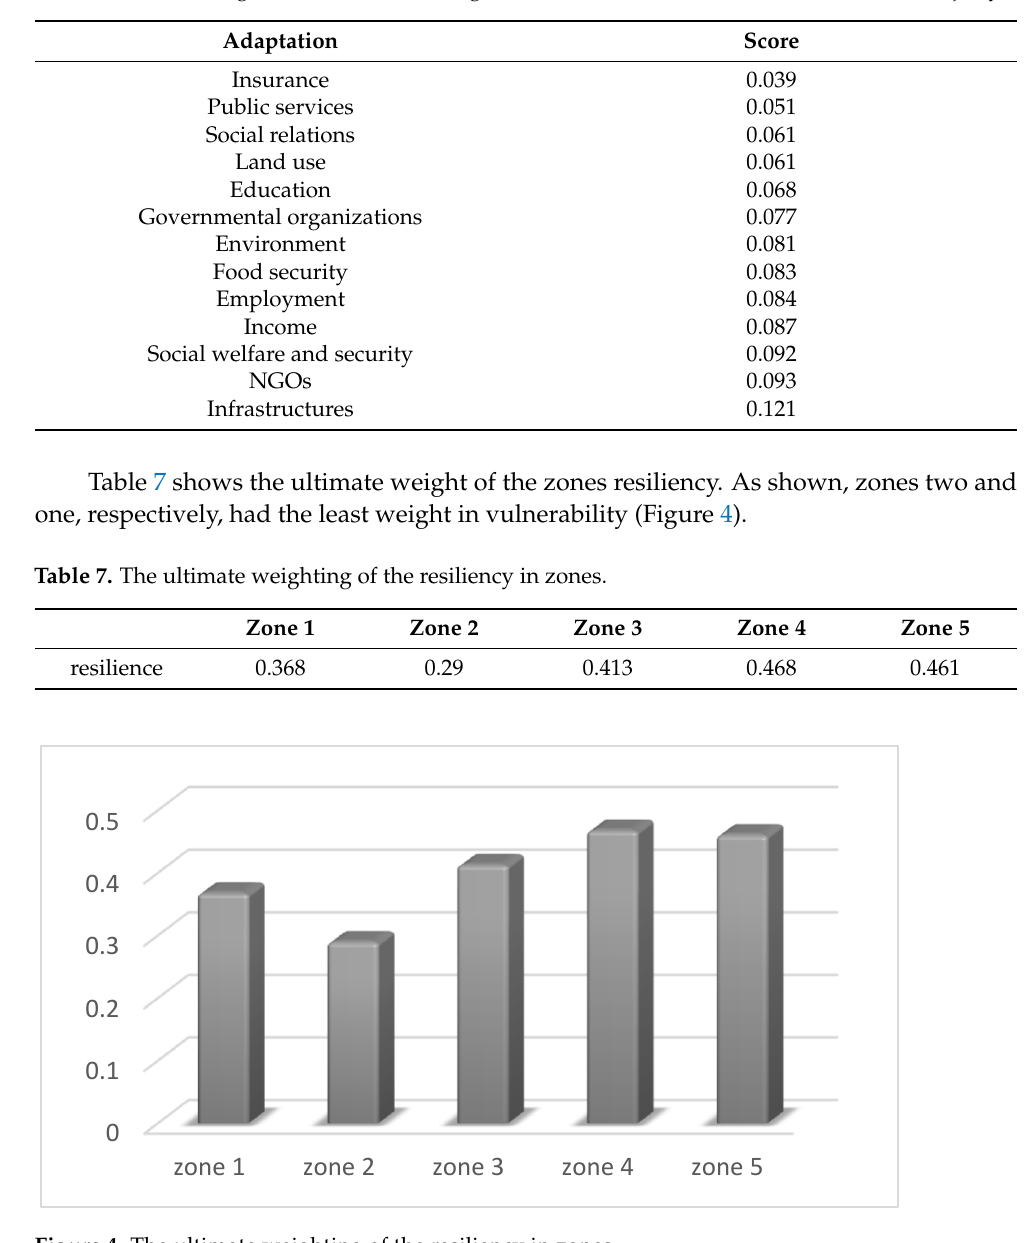
Table 6. The ordering of indicators according to the current situation in the zones of Sanandaj city.